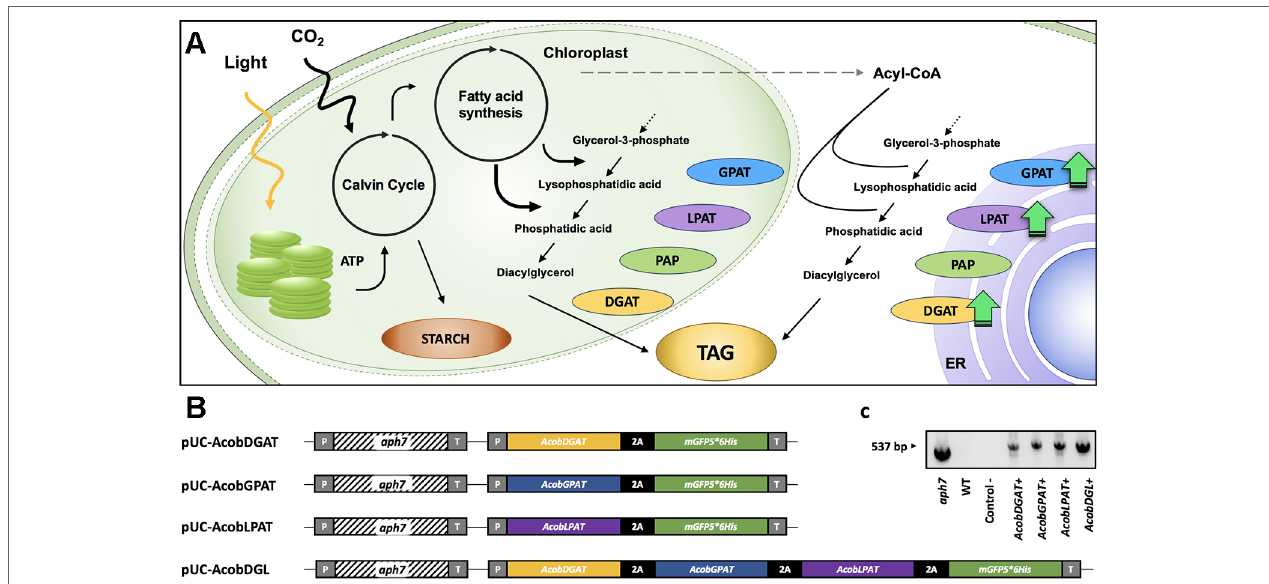
FigUrE 1 | TAG biosynthesis pathway (A) . glycerol 3-phosphate acyltransferase (GPAT), lysophosphatidic acid acyltransferase (LPAT), phosphatidic acid phosphatase (PAP), diacylglycerol acyltransferase (DGAT). Schematic representation of expression plasmids pUC-AcobDGAT, pUC-AcobGPAT, pUC-AcobLPAT, and pUC-AcobDGL (B) . PCR amplification of aph7 gene from wild type (WT) and transformant lines (C) . CaMV35S promoter (P), hygromycin B resistance gene aph7 , 3´ untranslated region CaMV (T), and 2A self-cleaving peptide of foot-and-mouth disease virus